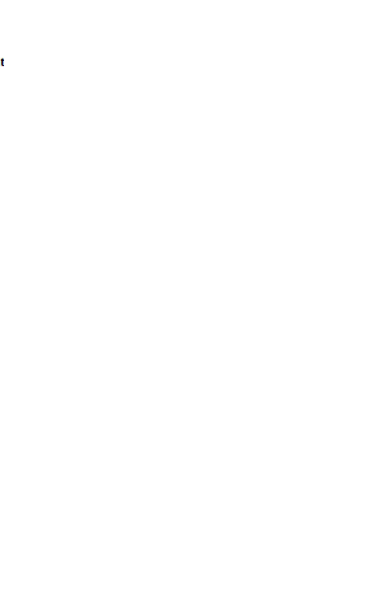
Fig 2. Comparison of select immunological parameters based on vitamin B 12 status.